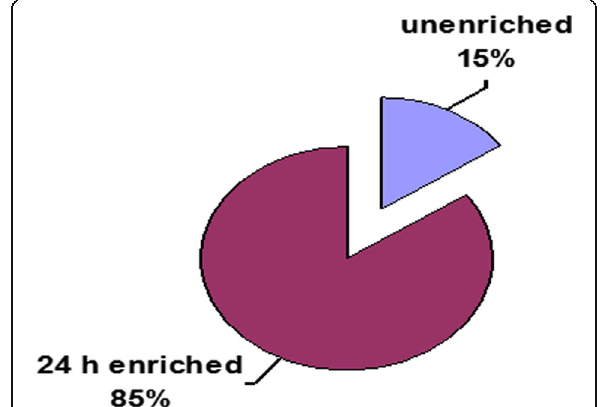
Fig. 6 The energy content (kJ/g) of enrichment A. tunisiana nauplii after 18 and 24 h from incubation